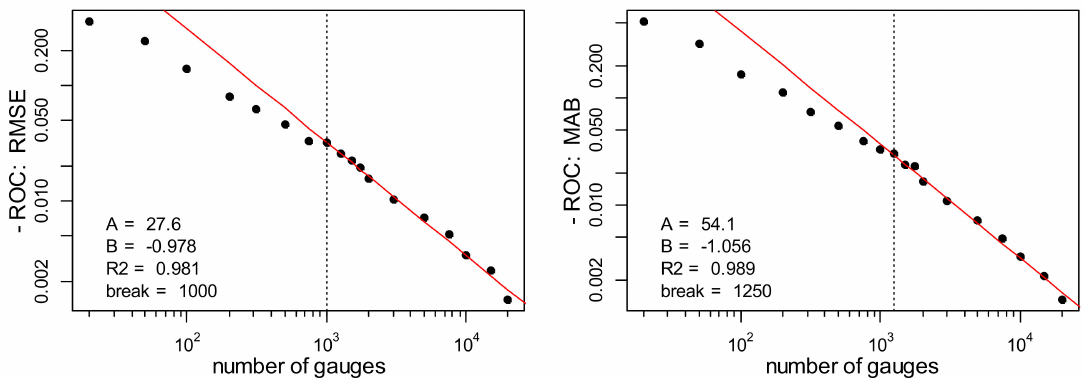
Figure 9. Rates of change: the median of the 24 wet days are in solid circles and the red line is the fitted power law; the ROCs are negative, so absolute values were used to allow fitting of the power law; the dashed vertical lines are the breaking points; y axis also on log10